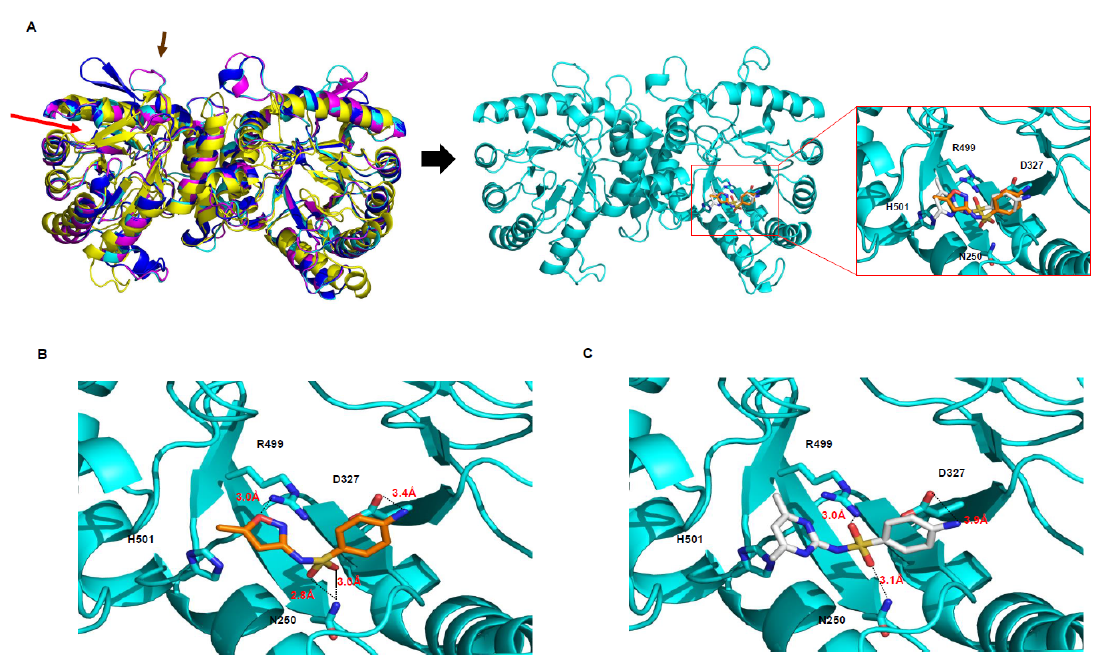
Figure 4. A docking model between sulfonamide and DHPS. ( A ) The dimeric form of DHPS rotated 90 ◦ . The target DHPS was designated from BcDHPS (Bra011157; cyan) for docking sulfonamides, and the red boxed region shows a zoomed-in view of only the active site for reaction with both sulfamethoxazole (orange) and sulfamethazine (gray). Red and brown arrows are the same as in Figure 3C. Docking view of sulfamethoxazole (orange, ( B )) and sulfamethazine (gray, ( C )) at the active site. The side chains of Asp 327, Arg499, His272, and Asn250 are close to nitrogen and oxygen on the sulfonamide ring. Cyan depicts an active site feature of the BcDHPS